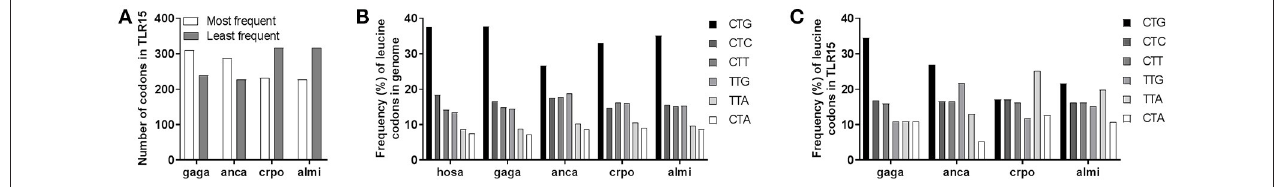
FIGURE 5 | Species-specific bias in TLR15 codon usage. (A) The number of most frequent or least frequent codons in chicken (gaga), anolis (anca), crocodile (cpro), and alligator (almi) TLR15 according to codon prevalence in the human genome (see also Supplementary Table 3 ). (B) Frequency of the six codons encoding the amino acid leucine in the genomes of Homo sapiens (hosa), Gallus gallus (gaga), Anolis carolinensis (anca), Crocodylus porosus (crpo), and Alligator mississippiensis (almi). (C) Frequency of leucine codons in TLR15 of the indicated